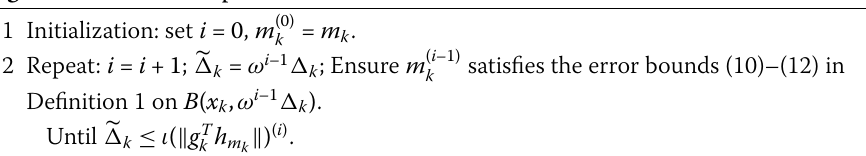
Algorithm 2 Model-improvement